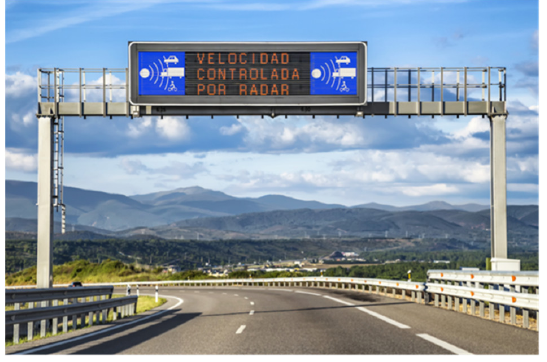
Figure 1. VMS example